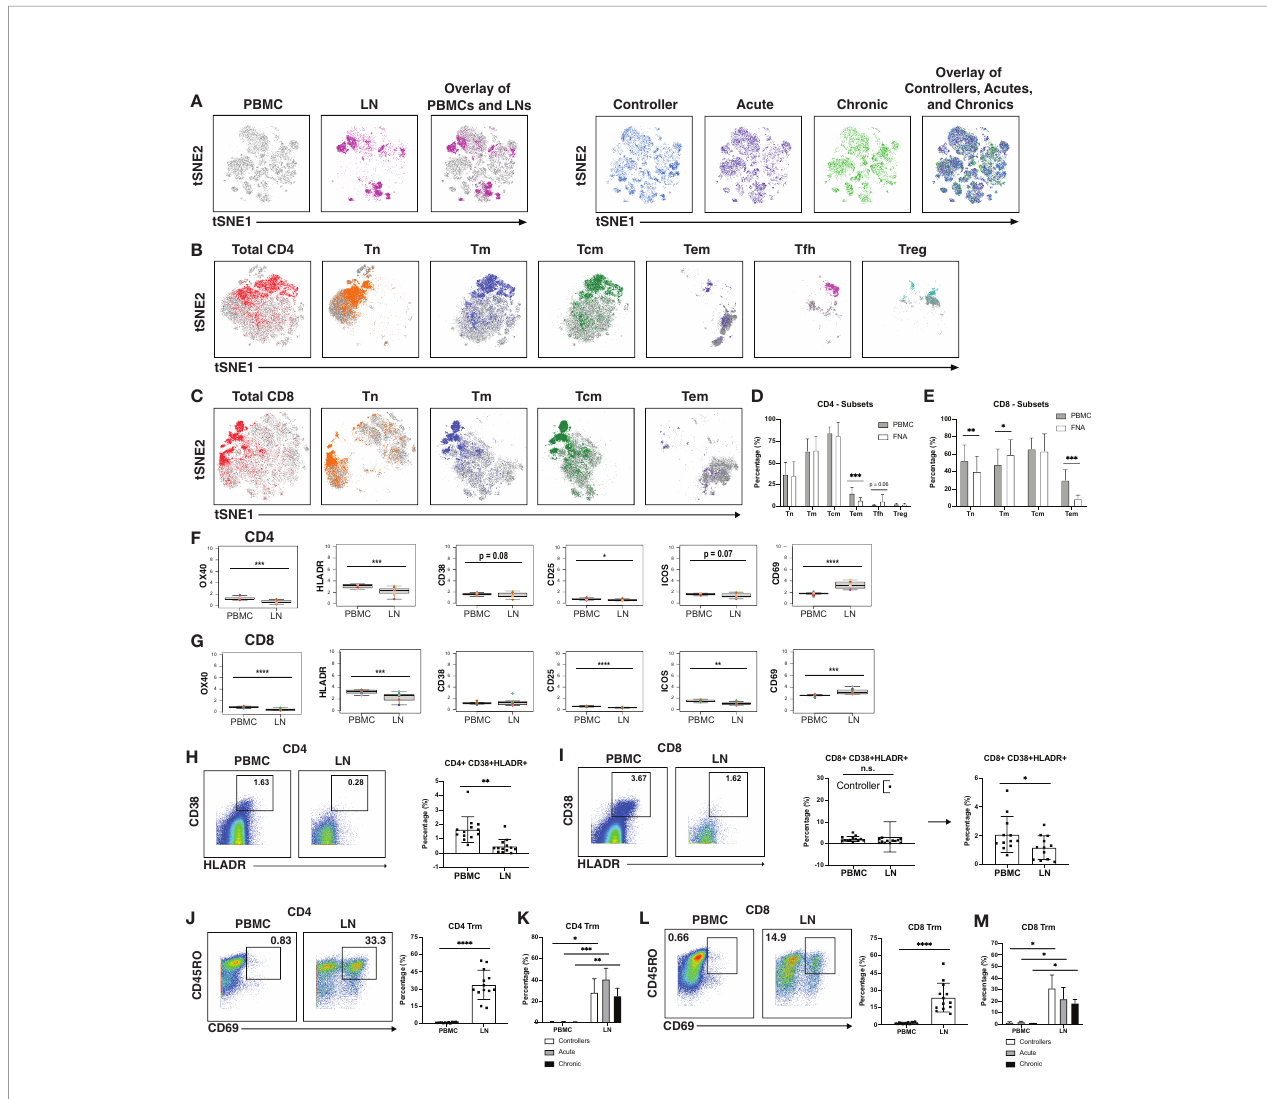
FIGURE 3 | Tcellsfrom bloodofPLWHaremoreactivatedthanthosefromlymphnodes. (A) tSNEplotsdemonstratingprofounddifferencesbetweenTcellsfromblood(grey) andLNs(colored;left),andmoresubtledifferencesbetweenpatientgroups(controllersinblue,acutely-treatedinpurple,andchronically-treatedingreen; right). (B) tSNEplots depictingphenotypicdifferencesamongsubsetsofCD4+Tcellsfromblood(grey)vs.LNs(colored). (C) tSNEplotsdepictingphenotypicdifferencesamongsubsetsofCD8+T cellsfromblood(grey)vs.LNs(colored).CD4+Tem (D) andCD8+TemandCD8+Tn (E) aremorefrequentinbloodthaninLNs.ShownarefrequenciesofTcellsubsetsrelative tototalPBMC(greybars) orLNs(whitebars),displayedasbar graphs.Cellsubsetsareasdescribedinthelegendfor Figure1C .CD4+ (F) andCD8+ (G) Tcellsfromblood expresshighlevelsofactivationmarkers,withtheexceptionofactivation/tissueresidencymarkerCD69.Shownarethemeansignalintensity(MSI) levelsoftheindicatedactivation markersassessedinTcellsfrom PBMCsandLNs.Dataaredisplayedasbargraphswithindividualdonors ’ valuesascoloreddots.Theremainingantigensarepresentedin FiguresS6,S7 .ActivatedCD38+HLADR+CD4+ (H) andCD8+ (I) TcellsaremorefrequentinPBMCsthanLNs.Gatesfor activationofTcellsduallyexpressingthetwo activationmarkersCD38andHLADR(left).Thebargraphs(right) showthepercentagesofCD38+HLADR+ TcellsinPBMCsandLNsamongalldonorsexamined.For CD8+T cells,oneextremeoutlier provedtobeanHIVcontroller;dataanalyzedafterremovingthisoutlier areshownonthefarright. (J , K) CD4+and (L , M) CD8+Tresidentmemory (Trm)cellsareenrichedinLNs,inallgroups.Trm cellswerede fi nedasthoseduallyexpressingCD45ROandCD69(left).TheirfrequenciesinPBMCsandLNsaredepictedasbar graphs(right). *p<0.05,**p<0.01,***p<0.001,****p<0.0001asdeterminedusingtheStudent ’